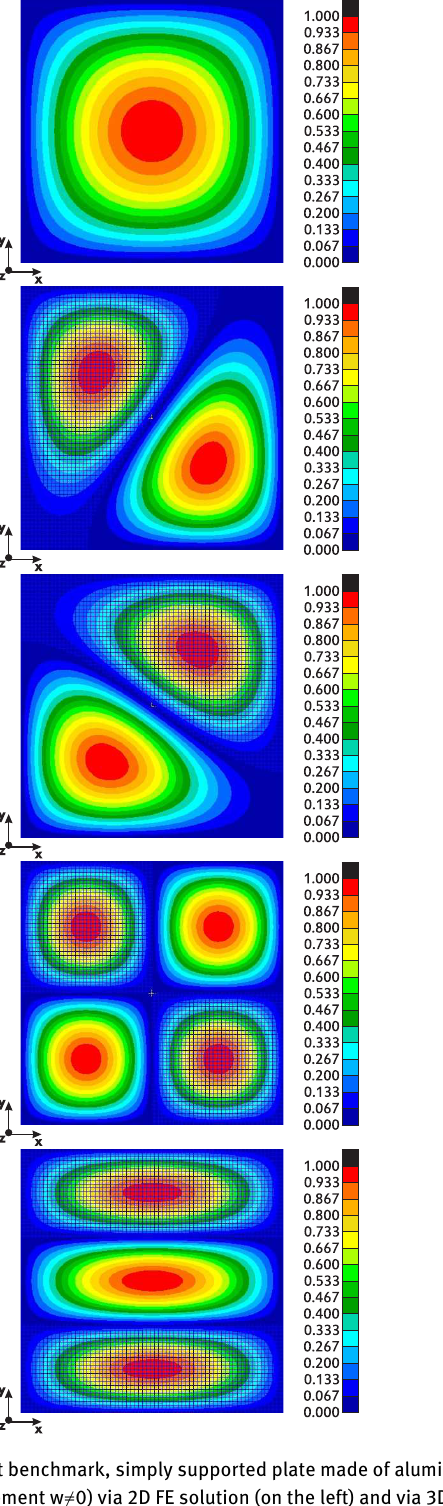
3D method. The 3D solution also gives another lower fre- quency for